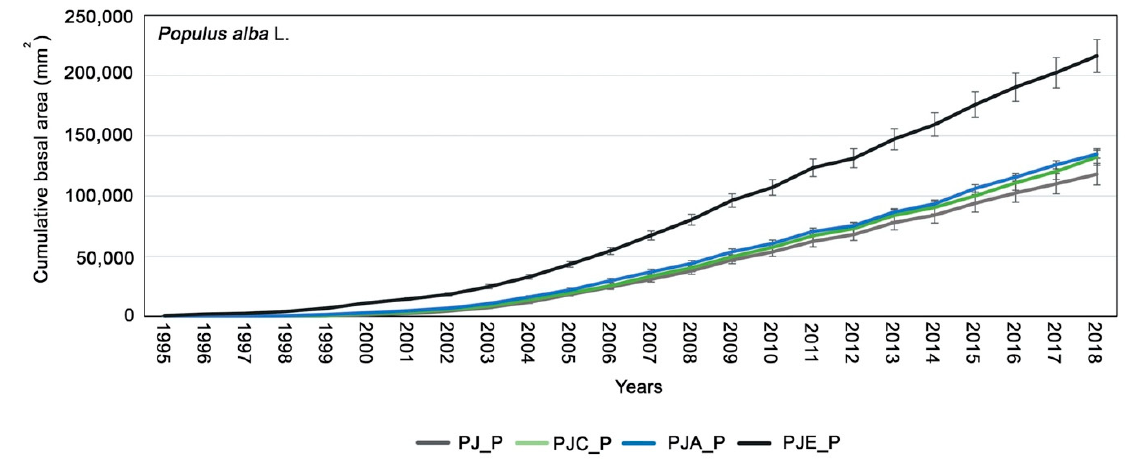
Figure 3. Cumulative basal area (CBA) calculated for Populus alba in the different systems: PJ_P in gray; PJC_P in green; PJA_P in blue; PJE_P in black. The bars indicate the standard error. Differences between intercropping systems were evaluated according to one-way ANOVA, using Student–Newman–Keuls coefficient for comparison tests ( p < 0.05).